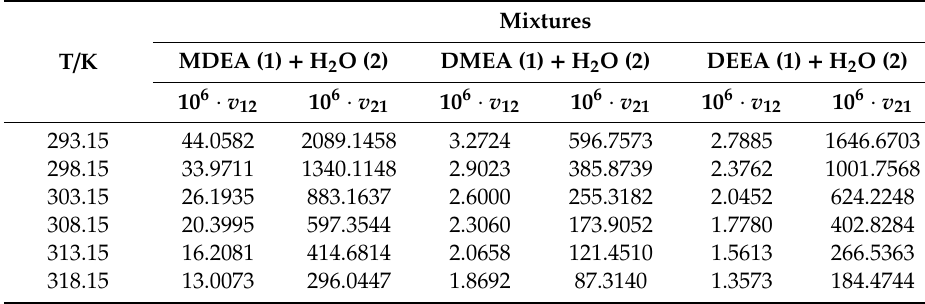
Table 8. Calculated parameters of McAllister’s three-body